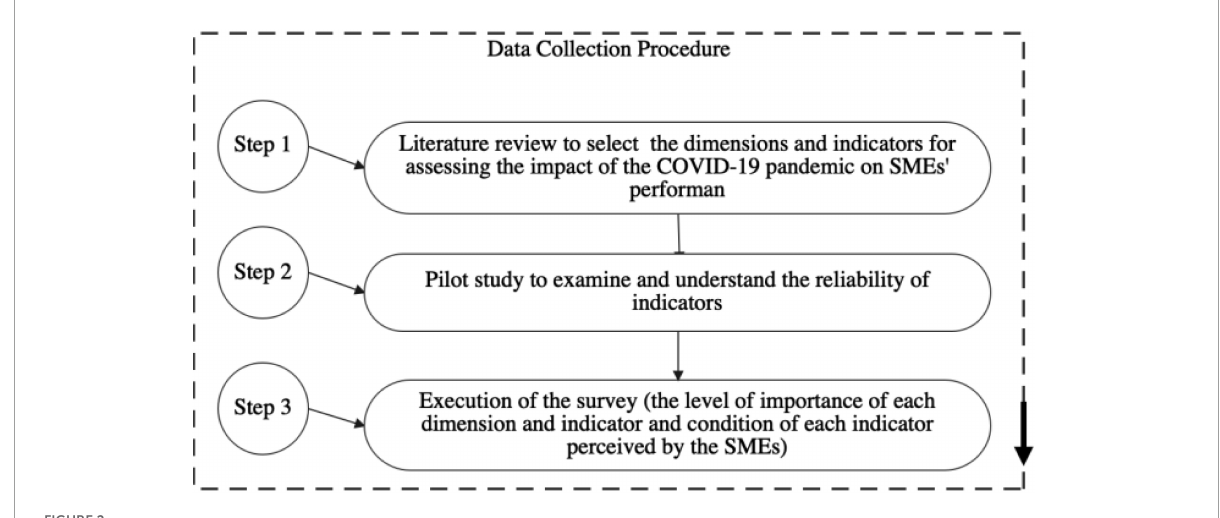
FIGURE2 Data collection